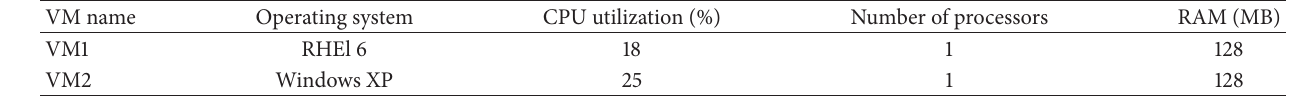
Table 5: Local list of node 2 (S1).